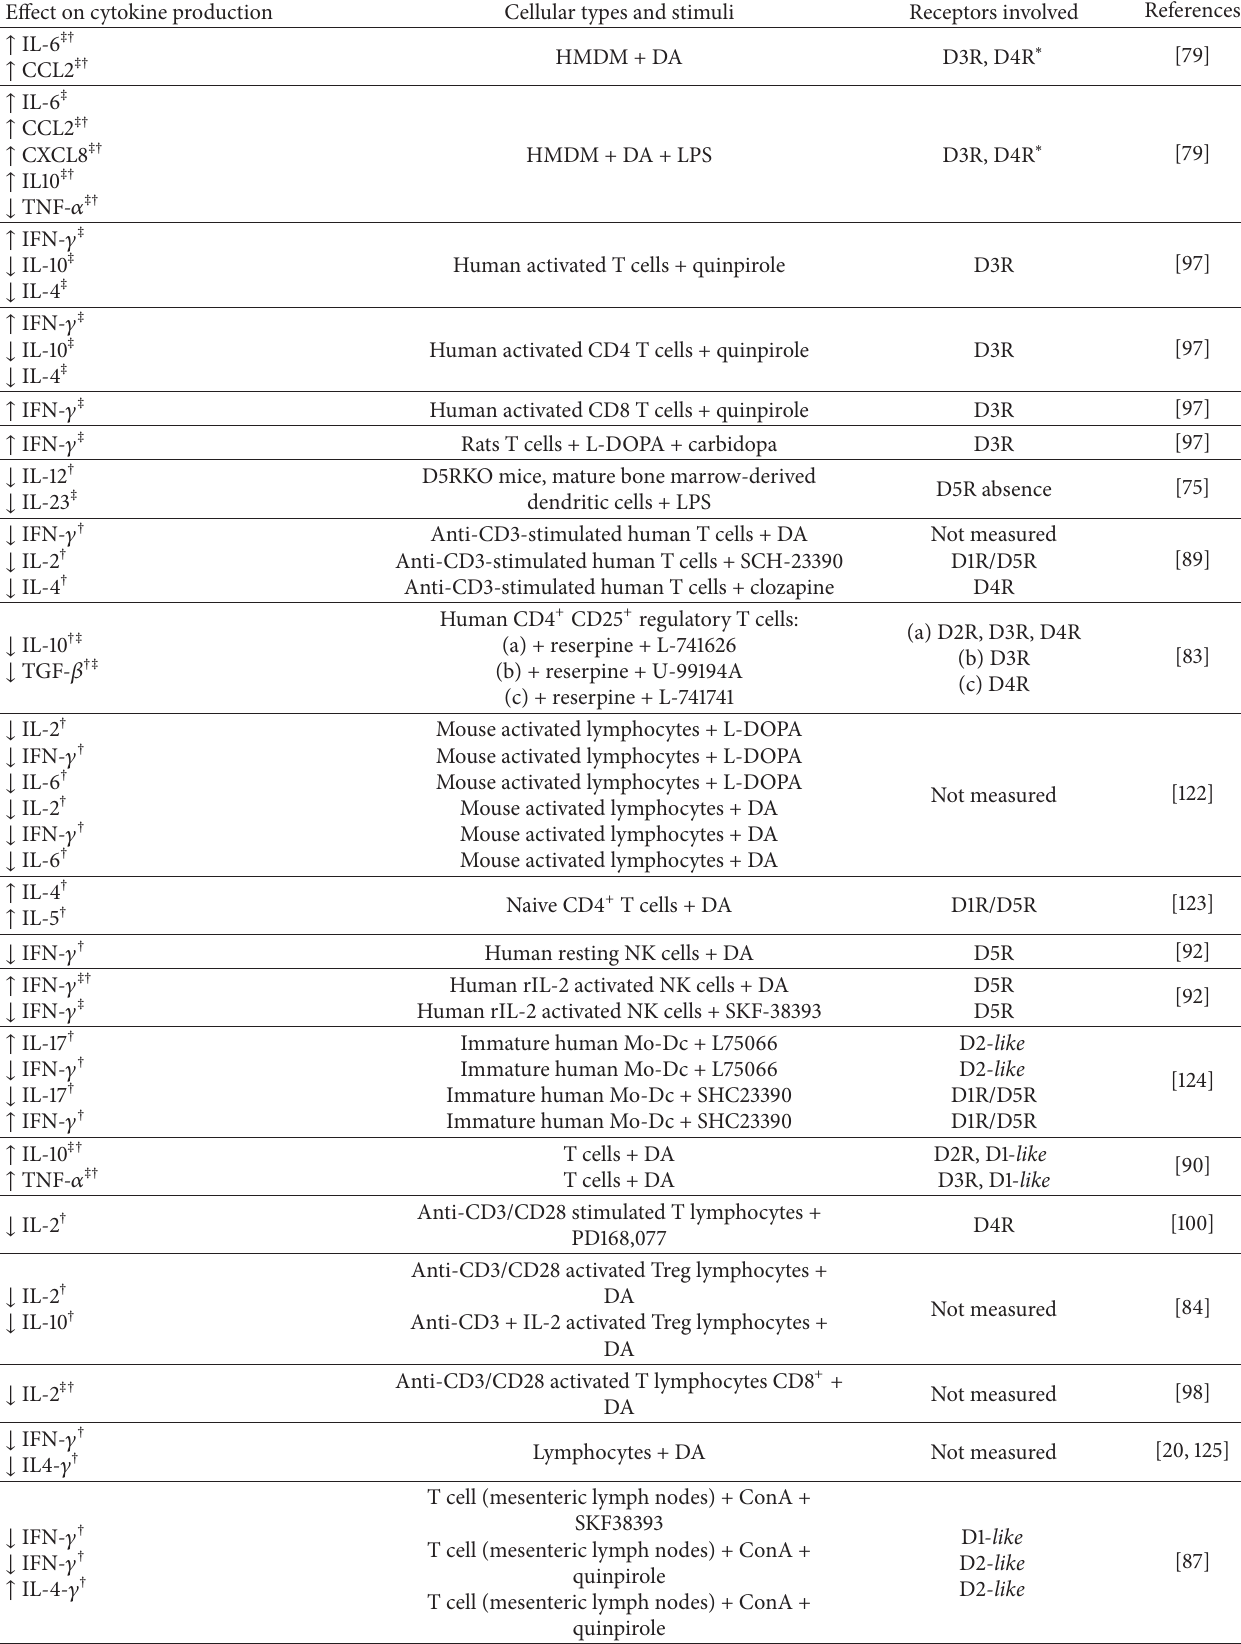
Table 3: The DRs effect on cytokine